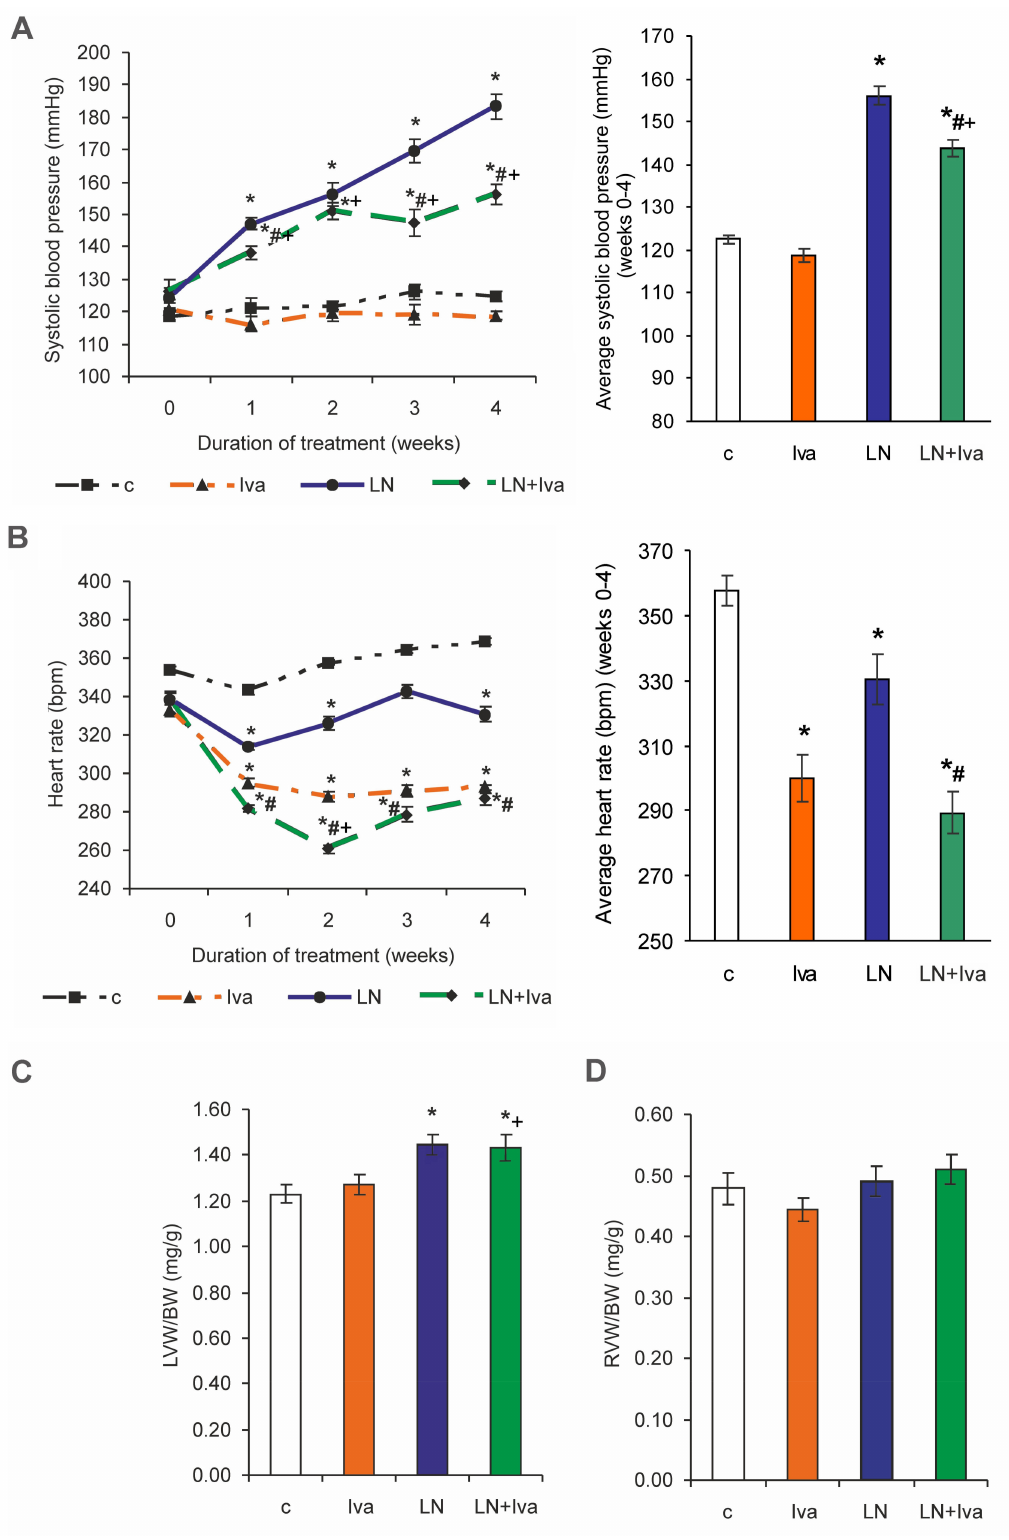
Figure 1. The influence of ivabradine (LN + Iva) on systolic blood pressure (SBP) and average SBP ( A ), heart rate (HR) and average HR ( B ), relative left ventricular weight (LVW/BW) ( C ), and relative right ventricular weight (RVW/BW) ( D ) in L-NAME-treated rats. Wistar controls (c); L-NAME (LN); ivabradine (Iva); n = 10 per group; * p < 0.05 vs. c; # p < 0.05 vs. LN; + p < 0.05 vs. Iva; results are expressed as mean ±